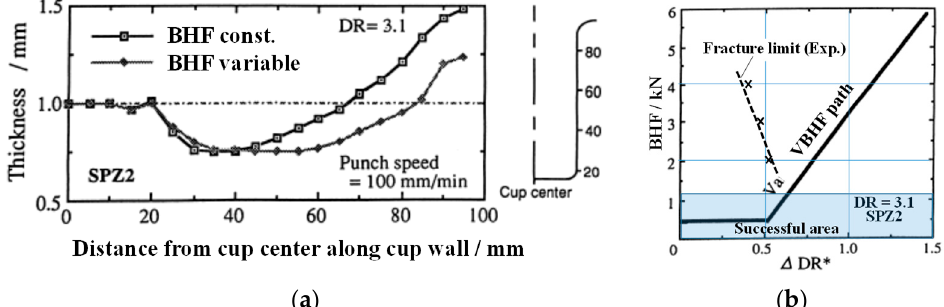
Figure 13. Comparison of thickness distribution of drawn cup by different BHF conditions. ( a ) Thickness distribution, ( b ) variable blank holder force (VBHF) path.